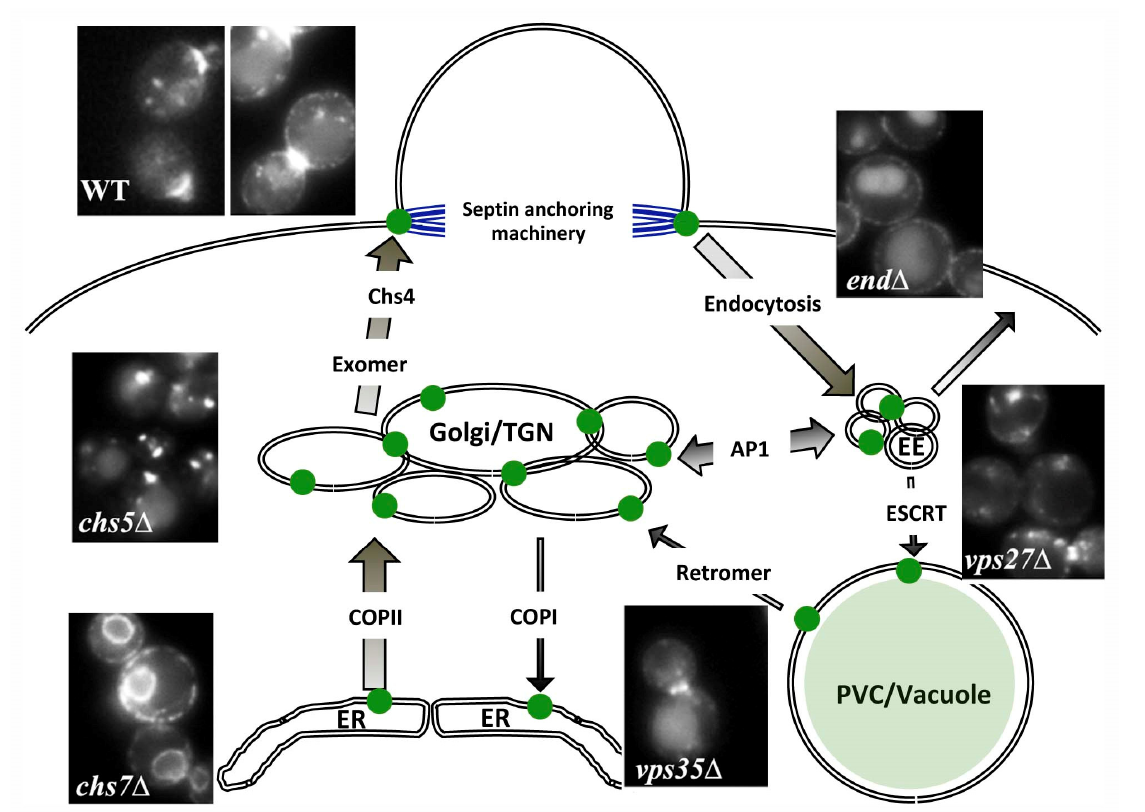
Figure 2. A visual scheme for chitin synthase 3 (Chs3) trafficking. Chs3 is synthesized in the endoplasmic reticulum (ER) where it is folded and later transported to Golgi in COPII vesicles. Misfolded proteins can be detected in the Golgi and returned to the ER via COPI vesicles. Chs3 is sorted in the trans -Golgi network (TGN) using exomer in order to be transported to the plasma membrane (PM) in a polarized way. On this journey, it interacts with Chs4, which elicits chitin synthase activity, allowing its anchorage to the neck region through specific machinery. Subsequently, the protein is endocyted, being recycled to the TGN from the early endosomal compartment by the AP-1 complex. In the absence of this recycling, Chs3 can escape to the PM though an alternative route. Only a small amount of the protein, which was ubiquitinated at the PM, is recognized by the ESCRT complex and delivered to the vacuole for degradation. Part of this protein can be recycled back to the TGN by retromer, avoiding degradation. Because of these efficient recycling mechanisms, most Chs3 accumulates in the TGN, forming a dedicated intracellular reservoir known as chitosomes. The early endosomal (EE) compartment has been depicted here for clarity, but its existence in yeast is questionable, and it is very likely that recycling by the AP-1 occurs within the TGN boundaries. The width of the arrows reflects the intensity of the traffic. The images show Chs3- GFP localization in the wild type (WT) and the indicated mutants: Chs3 accumulates normally at the neck region and in intracellular vesicles (chitosomes), while images from the mutants show the accumulation of the protein at the different intracellular compartments. chs7 ∆ : ER; chs5 ∆ : TGN/chitosomes; end ∆ :